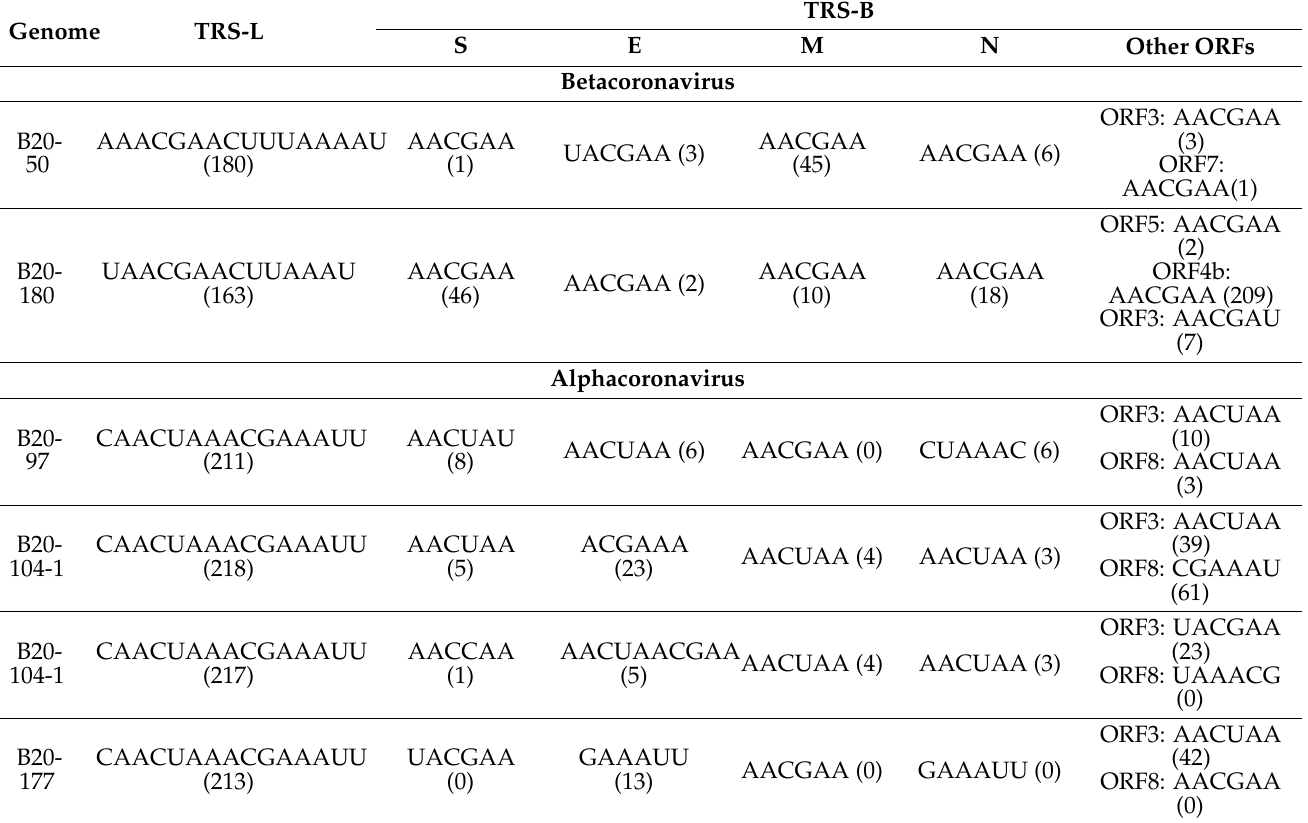
Table 2. Putative transcription regulatory sequences (TRS) of six genome sequences (distance base to AUG) .